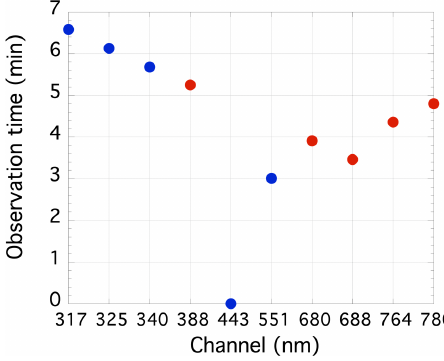
Figure 1. Observation time from the start of acquisition for each EPIC channel starting from 443nm. Red dots are the channels used for cloud retrievals. It takes about 7min to complete the 10-channel image